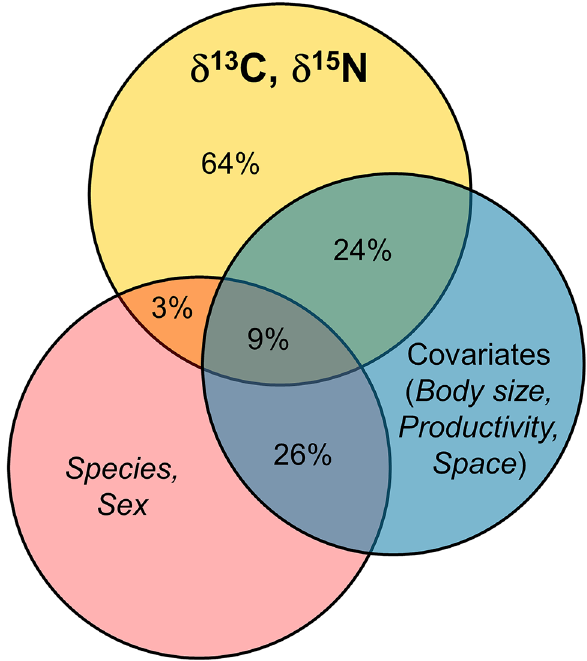
Figure 2. Venn diagram illustrating explained deviance estimated by variance partitioning. The yellow circle on top represents the total deviance of the response variables, whereas the red (bottom left) and blue (right) circles represent sets of predictors (species + sex and body size + productivity + space, respectively). The total deviance of each circle is set to unity. The area of the intersection between each of the predictors’ circles (red and blue) and the response (yellow) circle represents the deviance in the response variables that is explained by each set of predictors. The intersection of all circles is the variance jointly explained by the two sets of predictors. The intersection between the red and the blue circles represents the correlation between the two sets of predictors. The area of the yellow circle not overlapped by any other circle shows the proportion of response deviance not explained by the predictors.